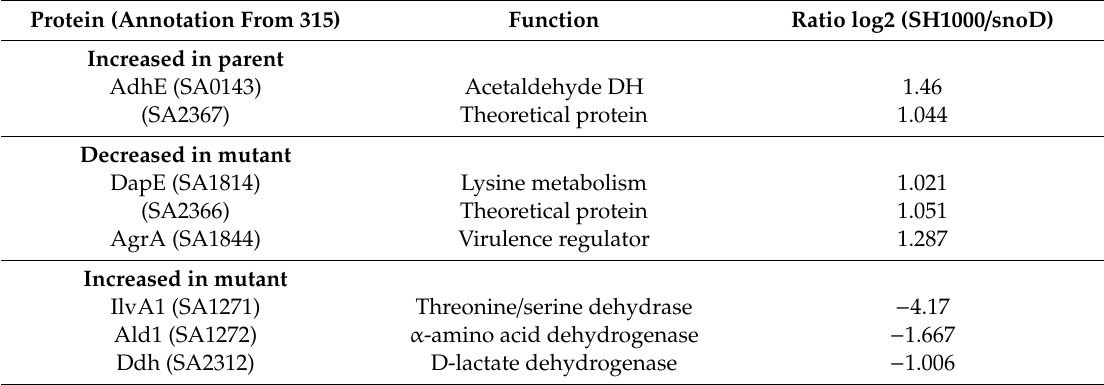
Table 1. Proteins of which the amount was a ff ected by snoD mutation under anaerobic conditions. Protein (Annotation From 315)